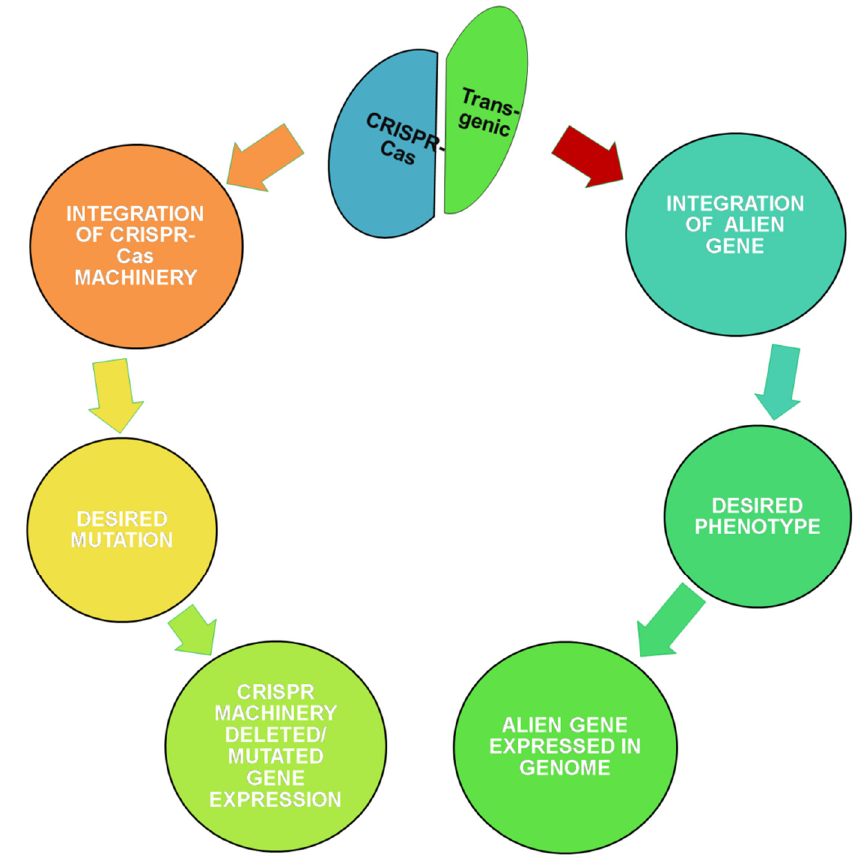
Figure 1. Illustration of CRISPR-Cas versus transgenic methodology and